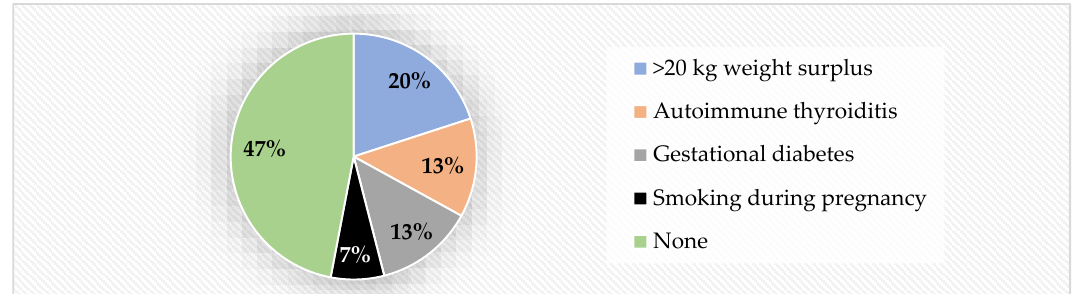
Figure 4. Mother ’s health during pregnancy, in overweight children.